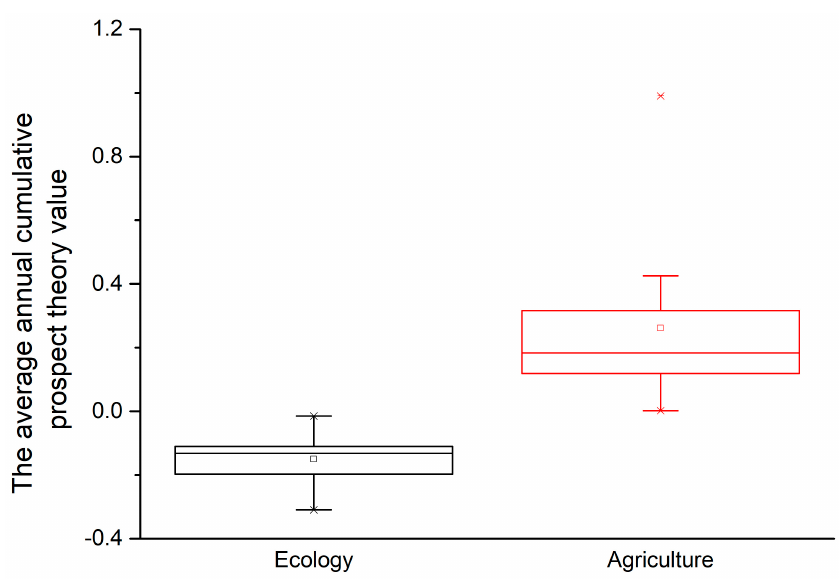
Figure 11. The cumulative prospect theory values for di ff erent water allocation scenarios in γ = 0.5 from 1990 to 2014.